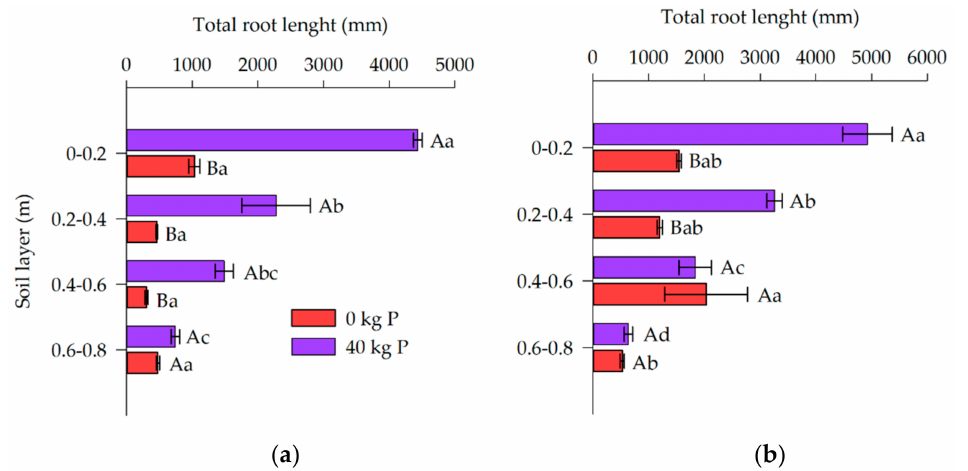
Figure 5. Total length of living roots (mm) in 0–0.2, 0.2–0.4, 0.4–0.6 and 0.6–0.8 m soil layers at 18 ( a ) and 36 months after transplant ( b ) in H. heptaphyllus plants subjected to applications of 0 and 40 kg P ha − 1 . ( a , b ) The uppercase letters compare P rate considering the same soil layer, while lowercase letters compare soil layers based on the Tukey test ( p < 0.05), since the interaction was significant at 5% based on two-way analysis of variance. Horizontal bars represent the standard error of three